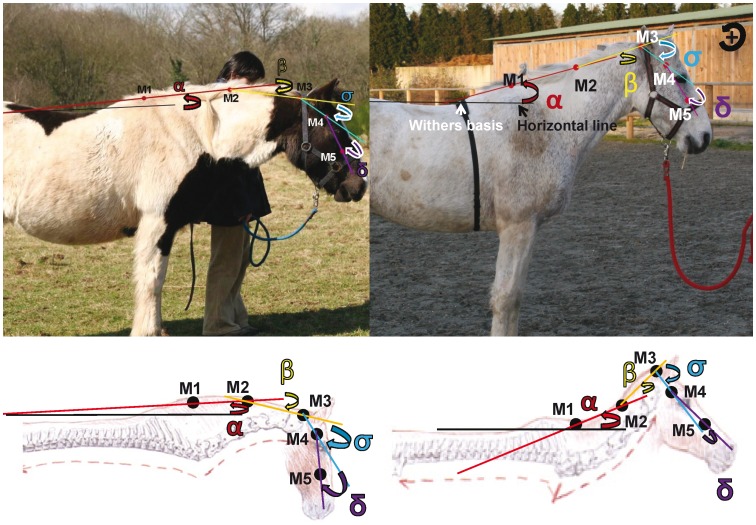
Representation of angles for neck posture measurement (Horse kept under natural conditions on the left and riding school horse on the right).α represents the neck’s elevation, β represents the neck’s curve and γ represent the M3–M5 angle (head-neck angle).